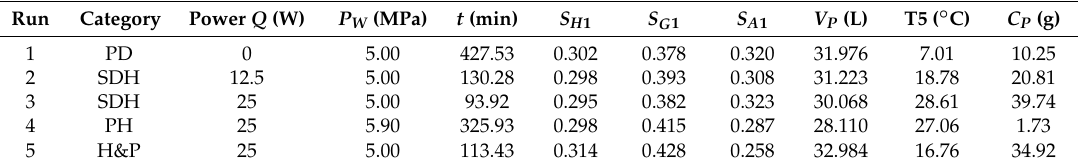
Table 1. Summary of experimental conditions and results of methane hydrate dissociation in the reactor in stage